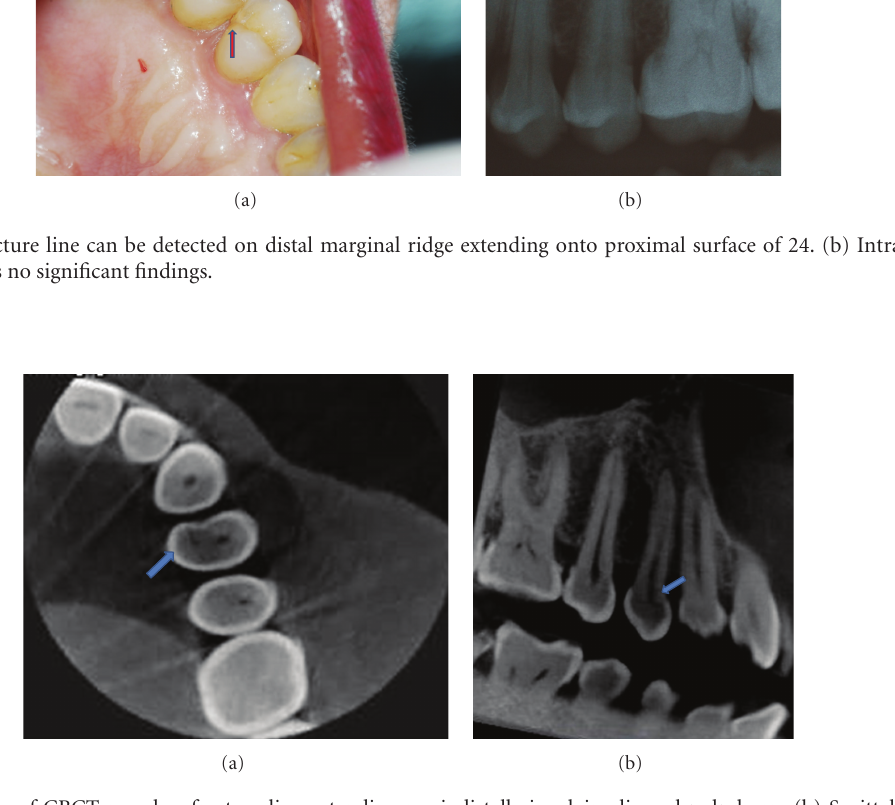
Figure 4: (a) Axial view of CBCT reveals a fracture line extending mesiodistally involving lingual pulp horn. (b) Sagittal view of CBCT reveals a fracture line extending mesiodistally at the level of pulp